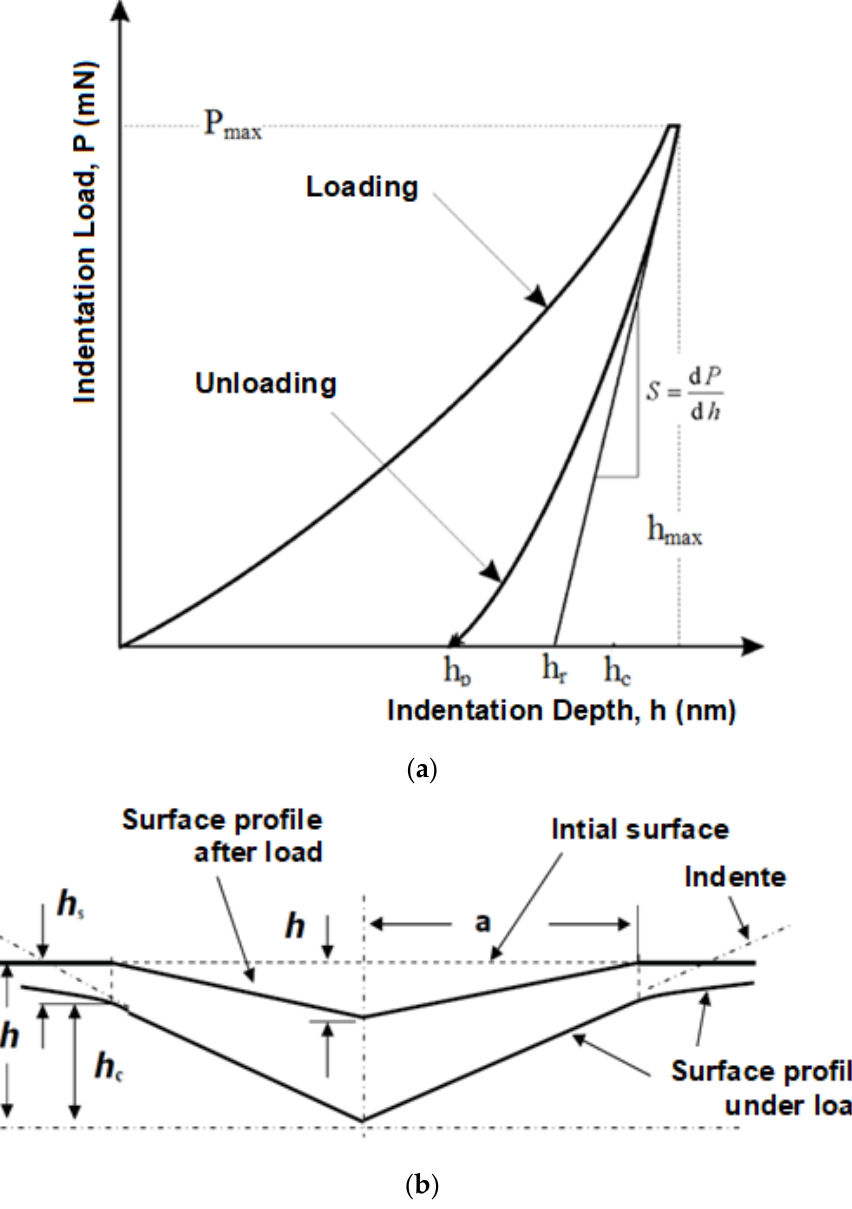
Figure 1. Principle of indentation: ( a ) load vs. indentation depth; ( b ) schematic representation of the indentation processes showing the decreasing of the indentation depth during loading (according to Oliver and Pharr).